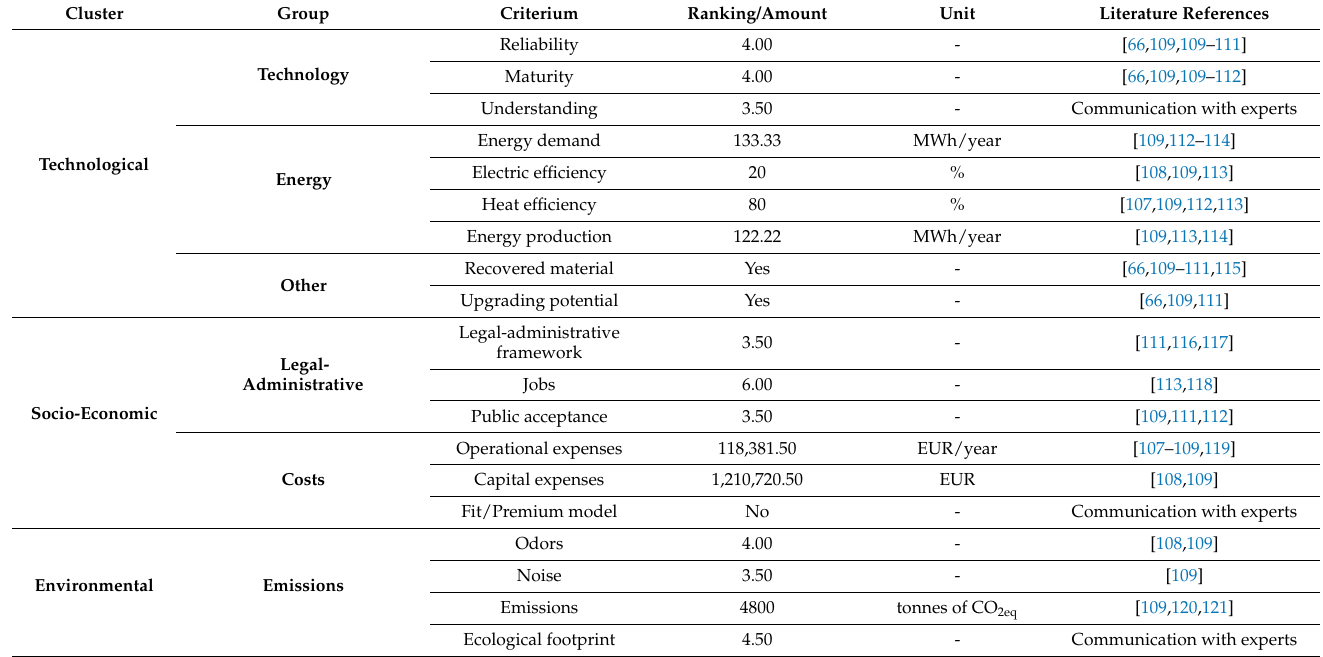
Table 6. Input data for the ranking of gasification technology.